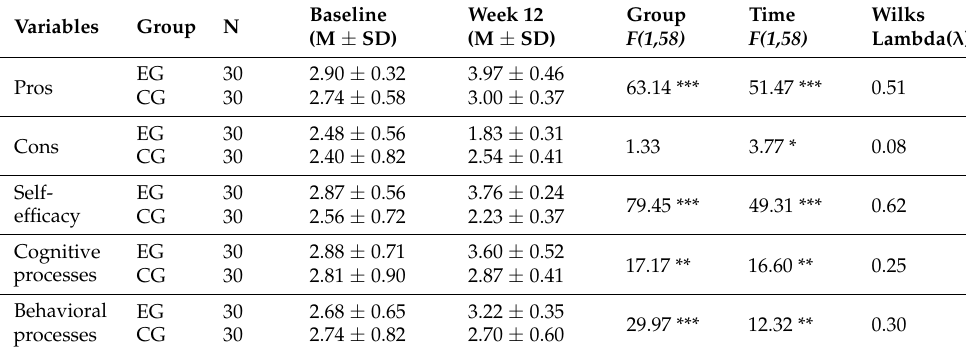
Table 5. Changes in psychological variables over the